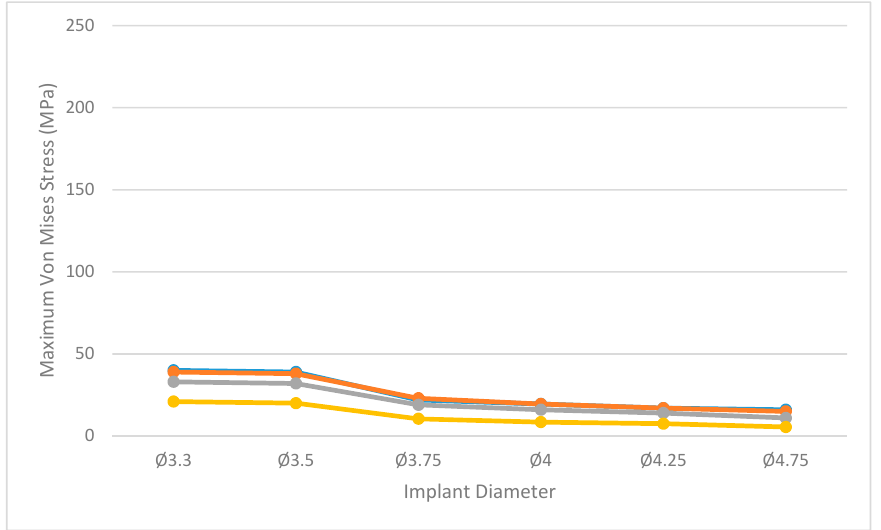
Figure 5. Maximum values of equivalent Von Mises stress (MPa) in bone tissue for each of the study scenarios under an axial load of 200 N. Bone type 0- I (yellow), bone type II (grey), bone type III (orange) and bone type IV (blue).